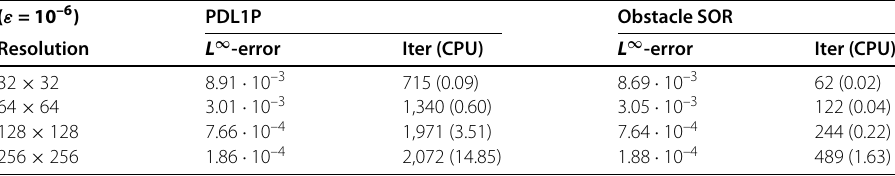
Table 2 L ∞ -errors, the number of iterations, and the CPU for linear obstacle problem with ϕ 2 (5.4) ( ε = 10 –6 ) PDL1P Obstacle SOR Resolution L ∞ -error Iter (CPU) L ∞ -error Iter (CPU) 32 ×